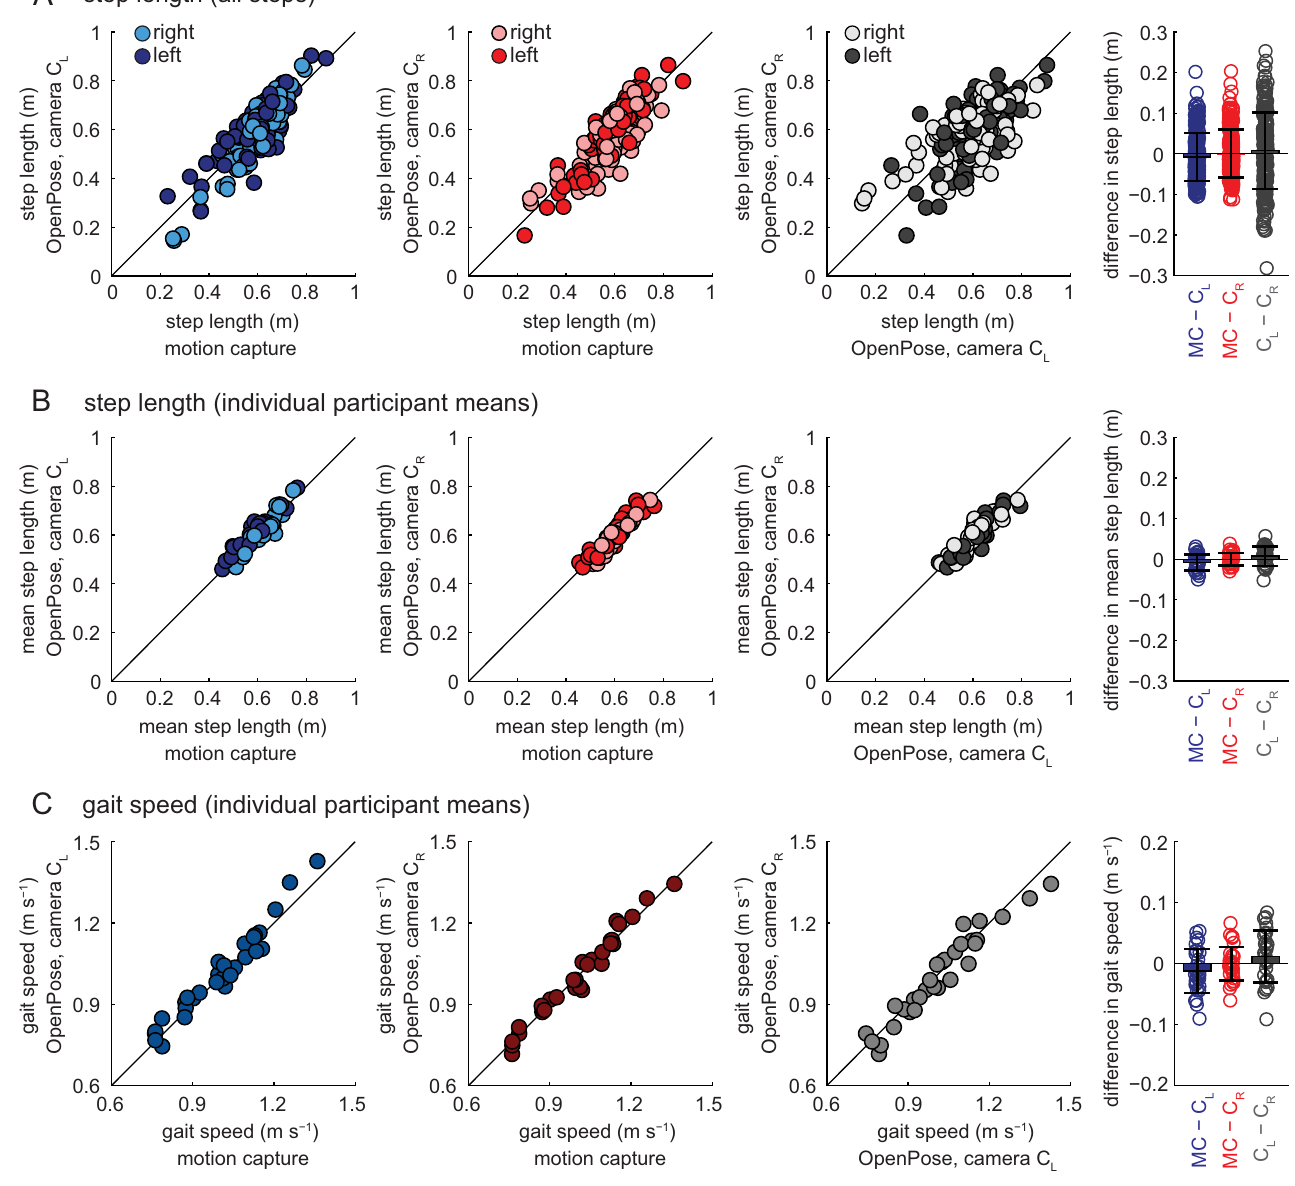
Fig 4. Step length and gait speed comparisons among the different measurement systems. A) Step lengths calculated for all individual steps for all participants and measurement systems. B) Step lengths calculated as individual participant means for all participants and measurement systems. C) Gait speeds calculated as individual participant means for all participants and measurement systems. Bar plots on the far right show individual data, group means, and SD to visualize the distributions of the differences observed between the measurement systems. Results from statistical analyses are shown in Tables